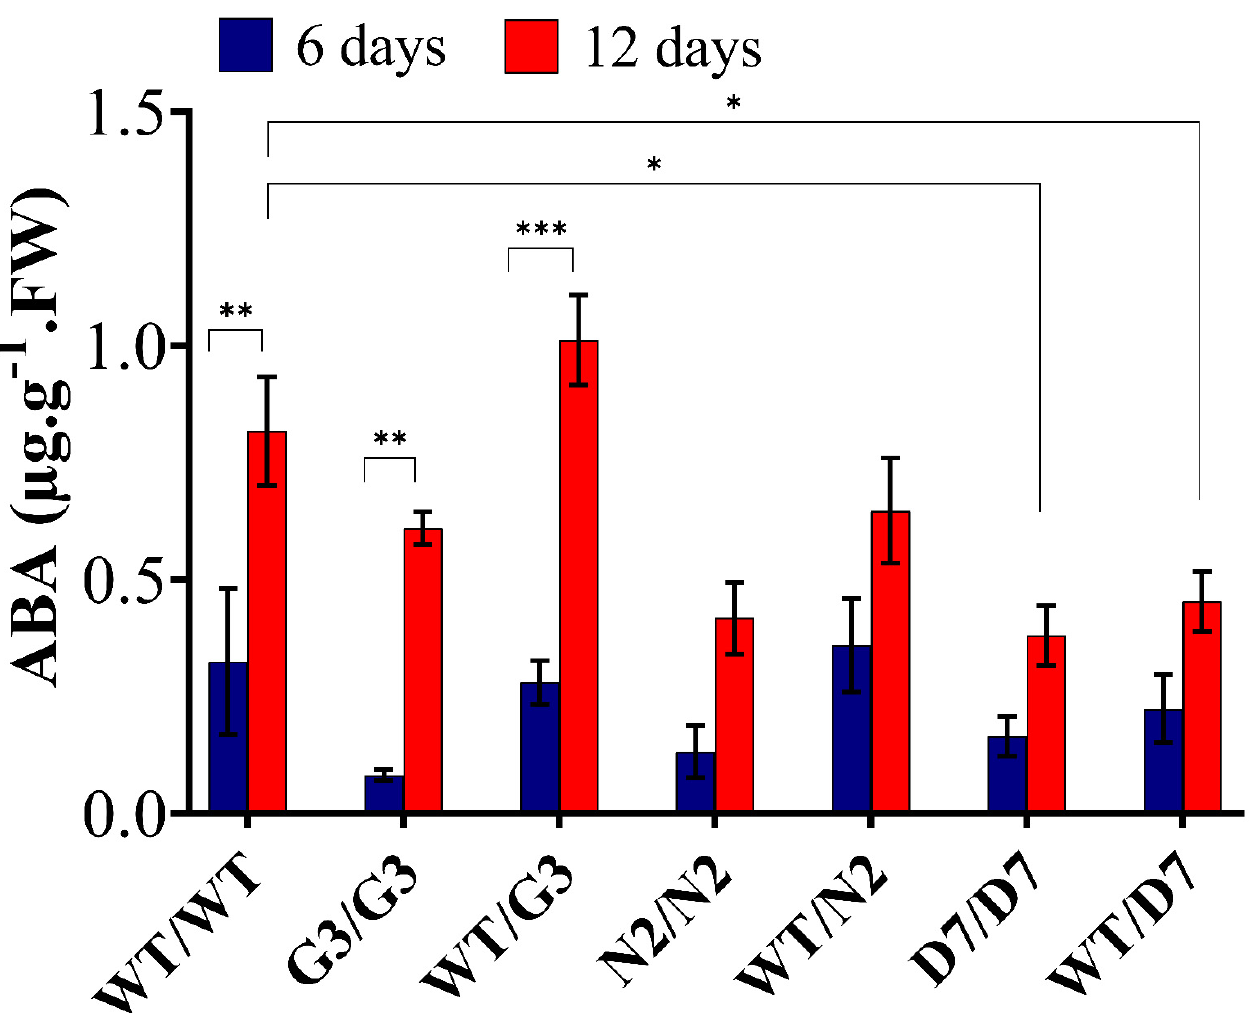
Figure 10. ABA quantification in the leaves of transgrafted tobacco plants under osmotic stress conditions. Abscisic acid (ABA) content was determined in the scion leaves 6 and 12 days of exposure to osmotic stress (10% PEG). WT/WT, G3/G3, WT/G3, N2/N2, WT/N2, D7/D7 and WT/D7 are grafting combinations. The bars represent mean values ± SEM of three biological replicates (four plants each). Asterisk(s) indicate(s) significant differences between the means of wild type (WT/WT) and transgrafts of each treatment group at * p < 0.05, ** p < 0.01, *** p < 0.001 according to Dunnett test.